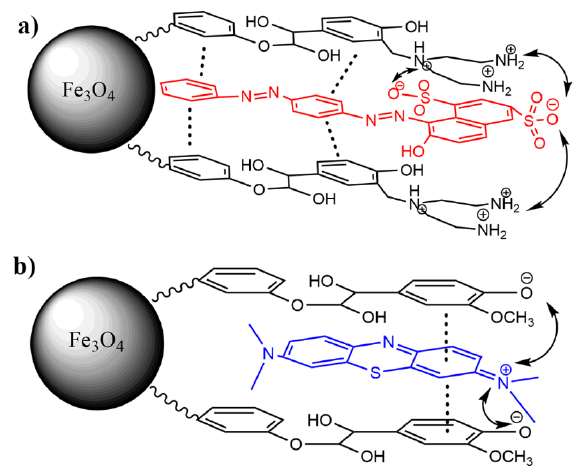
Figure 10. Adsorption profile of: ( a ) AS-GR onto LAMNPs under acid condition; and ( b ) MB onto LMNPs under alkaline condition. The dash and arrowed bonds present π – π stacking and electrostatic attraction interaction, respectively.